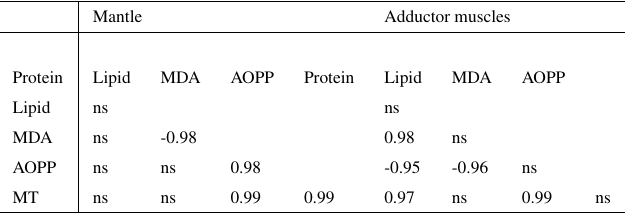
Table 2. Correlation analysis (Pearson correlation) between the biochemical parameters in the control and treated M. stultorun mantle and adductor muscle